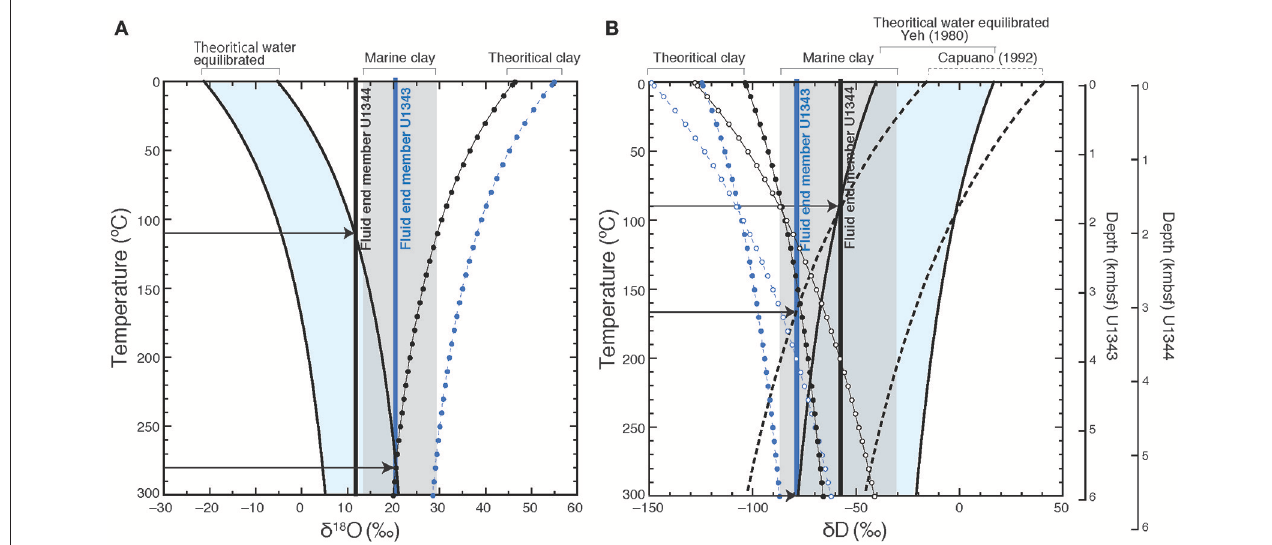
FIGURE 12 | The theoretical δ 18 O (A) and δ D (B) of water equilibrated with marine clay. Theoretical δ 18 O values of water (black solid curve) are calculated after Sheppard and Gilg (1996) at different temperatures on the basis of the previously reported δ 18 O values of marine clay (gray shaded), and those δ D-values are calculated after Yeh (1980) (black solid curve) and Capuano (1992) (black dashed curve). The range of the theoretical δ 18 O and δ D-values are light blue shaded. The blue circles and dashed lines show the theoretical isotopic compositions of clay equilibrated with fluid end member for Site U1343, and the black ones show those for Site U1344. Black arrows indicate the intersection between the end-member values and theoretical theoretical δ 18 O and δ D-values of